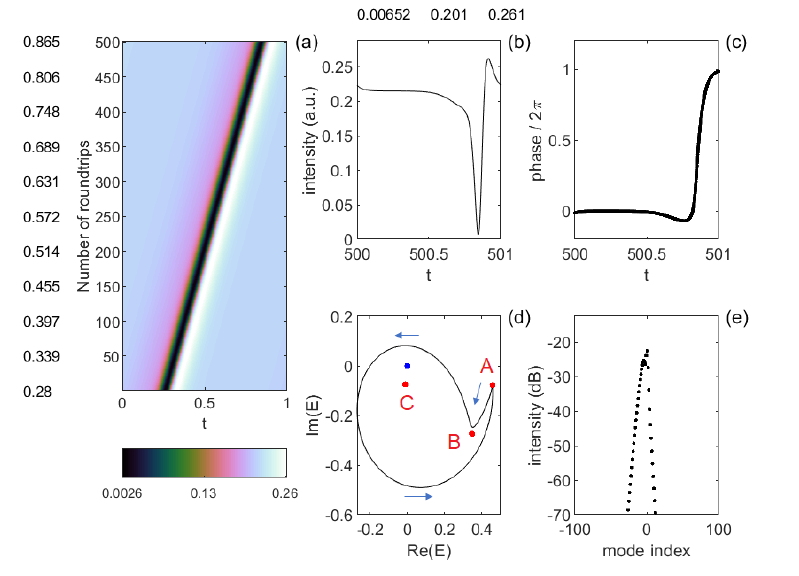
Figure 4. ( a – e ) Same as Figure 2 but with b = 10. The phase soliton is wider and slower.